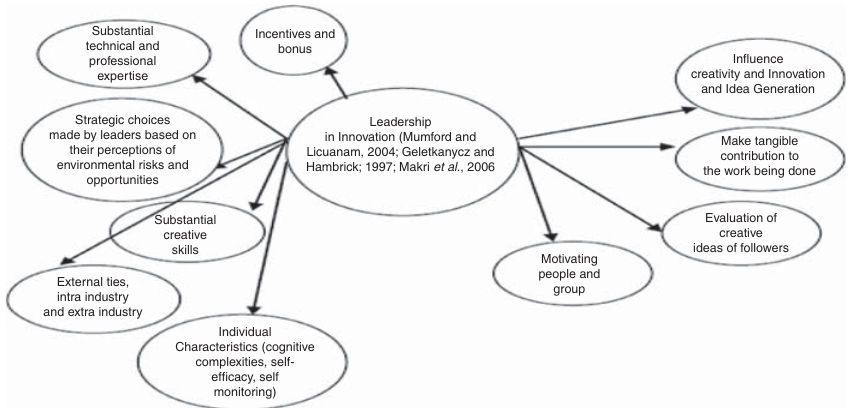
Figure 1. Conceptual